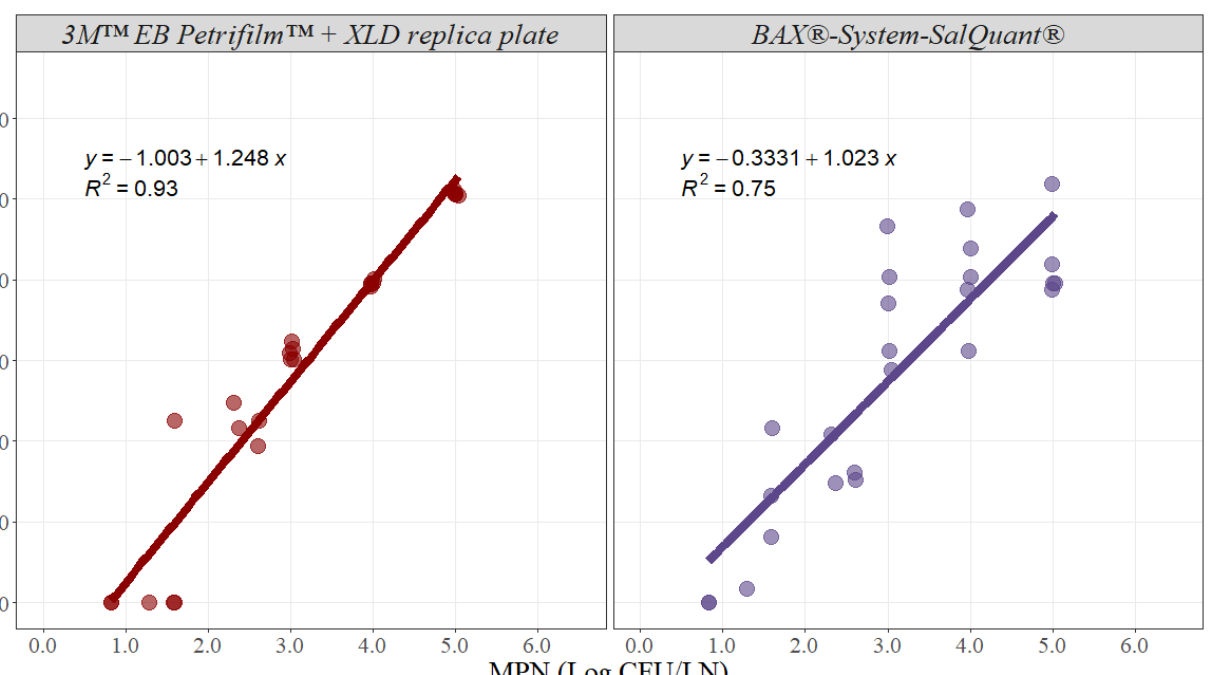
ods (Figure 3). The intercept value for the 3M™ EB Petrifilm™ + XLD replica plate method was − 1.003 with a 95% confidence interval from − 1.501 to − 0.505, while the intercept for the BAX ® -System-SalQuant ® method was − 0.333 with a 95% confidence interval from − 1.186 to 0.519 in pork lymph nodes (Table 1).